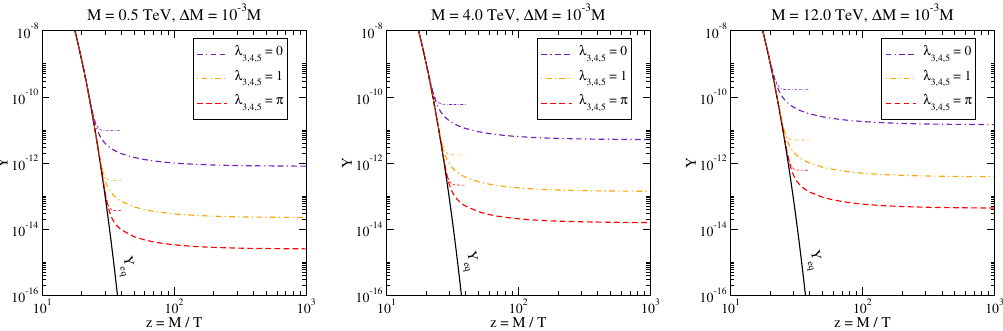
Figure 5 . The evolution of the yield parameter for various masses and scalar couplings, as a function of z (cid:17) M=T . The scalar couplings are evaluated at the scale (cid:22) (cid:22) = 2 M , we have set (cid:21) (2 M ) = (cid:21) (2 M ) = (cid:21) (2 M ), and (cid:1) M = 10 (cid:0) 3 M . Thick lines correspond to the Lee-Weinberg 3 4 5 equation in eq. (3.1), and thin lines to the linearization in eq. (3.4), which is a good approximation for the initial